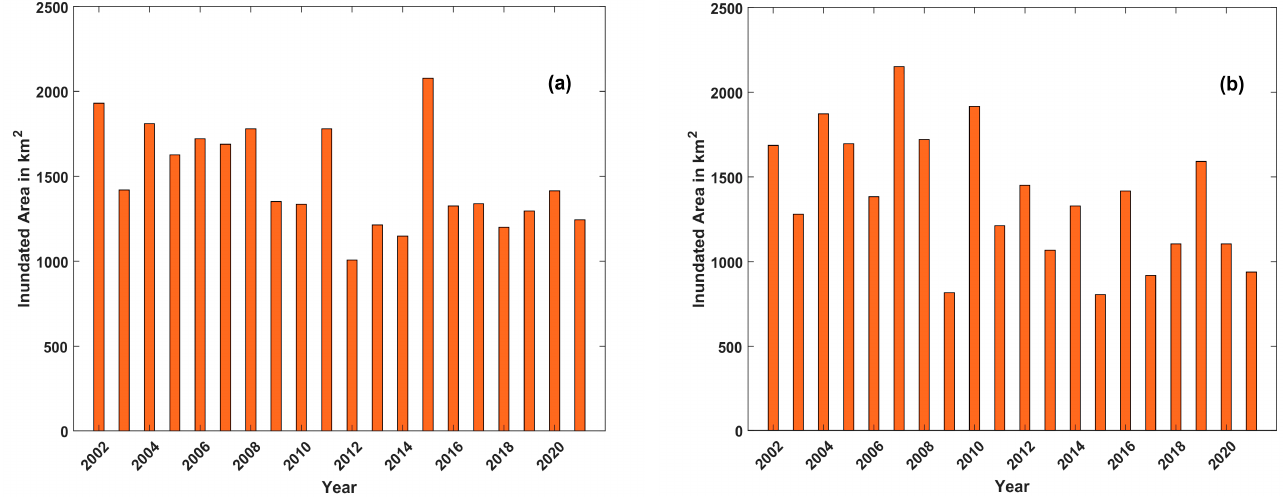
Figure 3. Annual inundated area in ( a ) wet season and ( b ) dry season from 2002–2021.